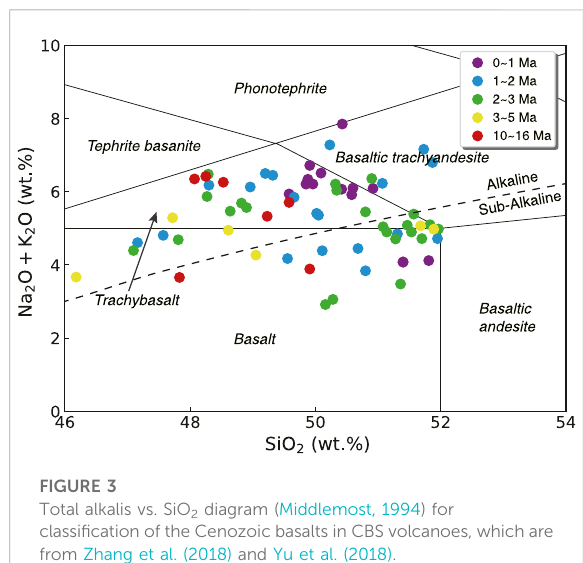
FIGURE 3 Total alkalis vs. SiO 2 diagram (Middlemost, 1994) for classi fi cation of the Cenozoic basalts in CBS volcanoes, which are from Zhang et al. (2018) and Yu et al.